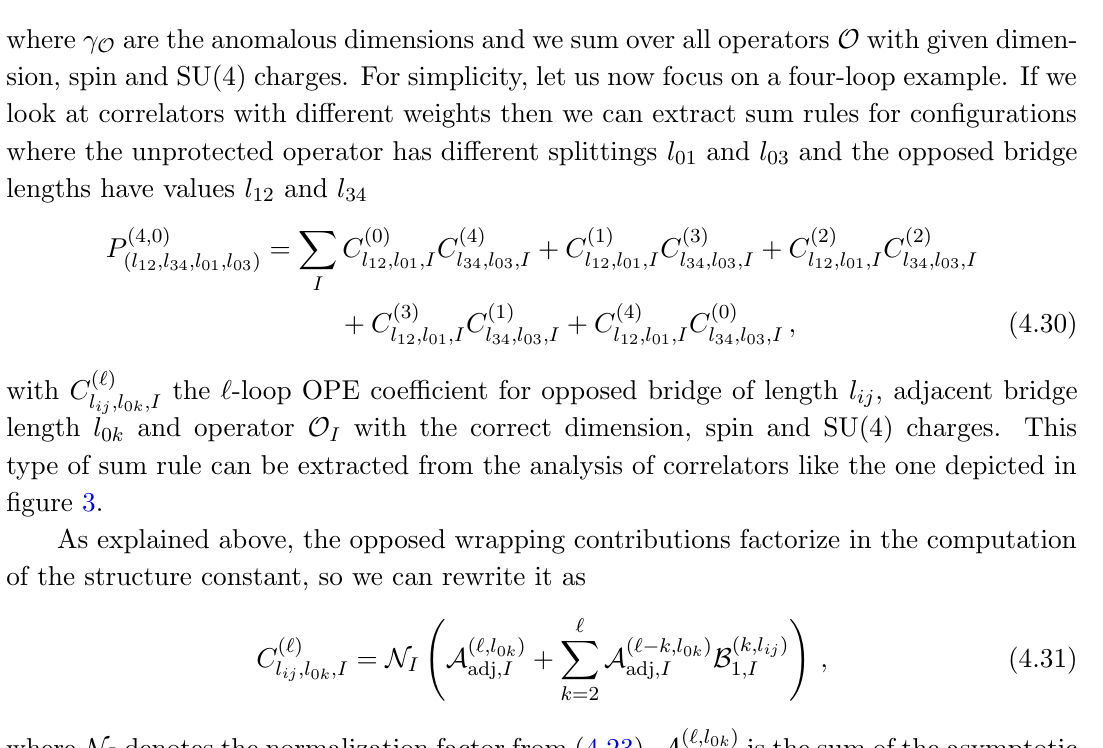
Figure 3 . Example of a four-point correlator where blue lines denote contraction between X and (cid:22) X , red lines connect Y and (cid:22) Y and all other lines correspond to Z and (cid:22) Z (cid:12)elds. The leading operators in the OPE limit have twist 4, and we get a product of distinct structure constants. The OPE coe(cid:14)cient in the top has equal splitting between adjacent bridges and opposed bridge of length 4, so that virtual excitations in those lines do not contribute at four loops. Meanwhile the OPE coe(cid:14)cient in the bottom half has an assymetric split between left and right adjacent bridges, and the opposed bridge has length one, which implies the appearance of opposed wrapping at two